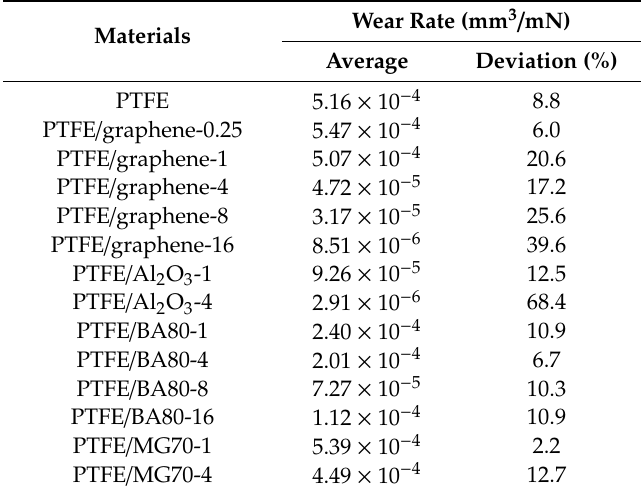
Table 9. The measured wear rates of the tested unfilled / filled PTFE.